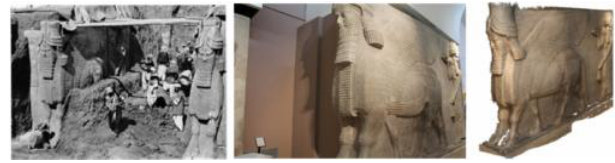
Figure 4. Lamassue: Excavation activities, location in the museum and 3D point cloud